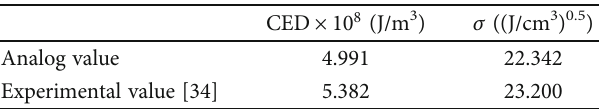
Figure 4: Temperature and energy distribution during the fi nal NPT-MD simulation of the PVDF (a, b) and BT20/PVDF (c, d) hybrid system. Table 2: Simulated and experimental values of PVDF cohesive energy density and solubility